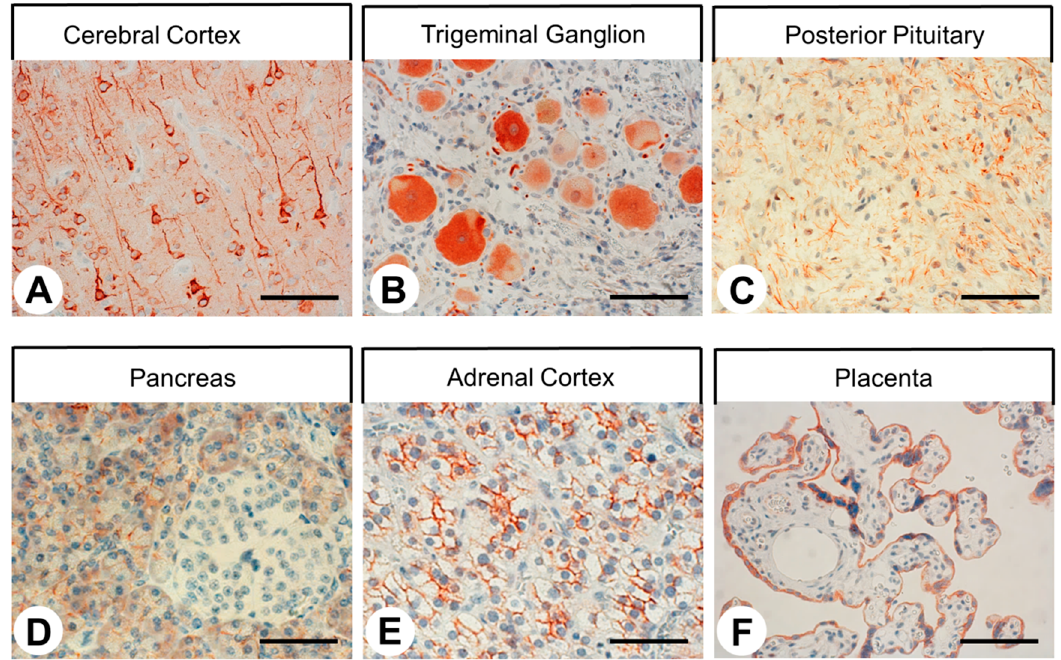
Figure 5. SST4 expression in different normal human tissues. SST4 was detected immunohistochemically in sections of human tissues using antibody 7H49L61. Scale bar: ( A , B , C , F ) = 100 µm; ( D , E ) = 60 µm.